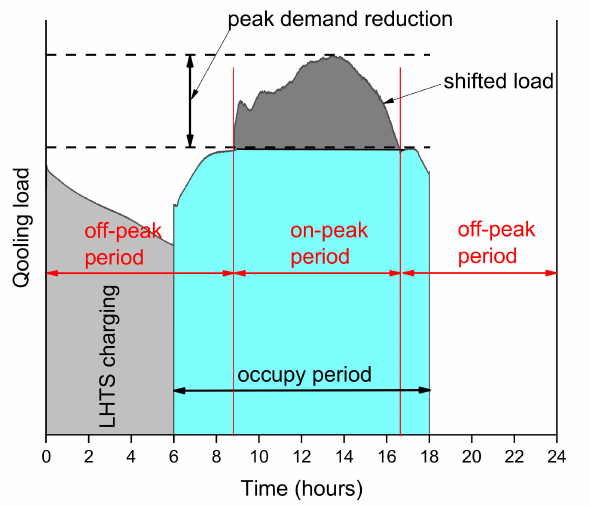
Figure 1. Building cooling load profiles for one day, illustrating the load shifting